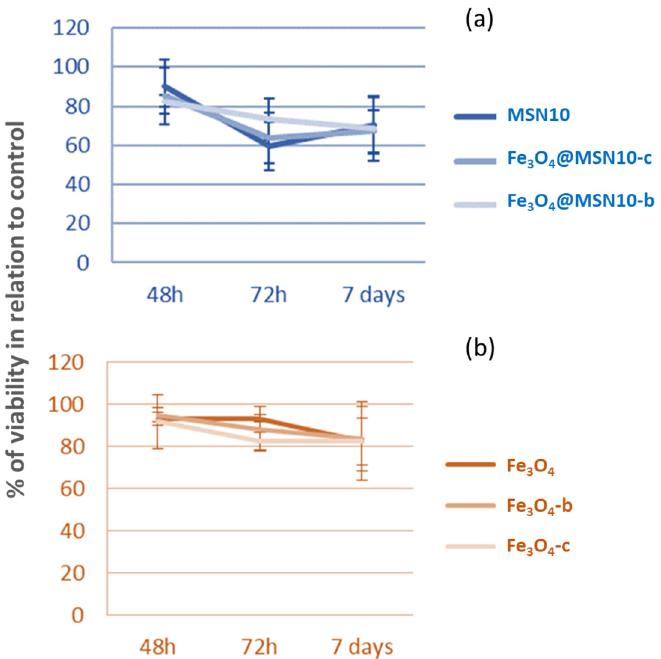
Figure 10. Influence of 70 µ g/mL of Fe 3 O 4 @MSNs ( a ) or Fe 3 O 4 NPs ( b ) on cell viability in DLD1 colon cancer cells at different times. Cells were treated with 70 µ g/mL of the six nanoparticles and viability was measured by MTT assay at 48 h, 72 h, or 7 days.